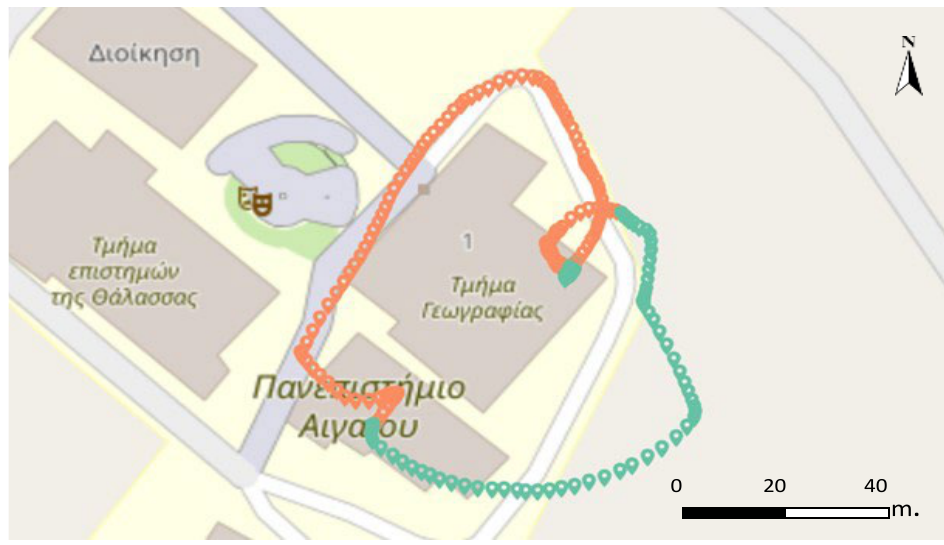
Figure 11. Recording (orange) and non-recording (green) segments of an ST over campus at University Hill.